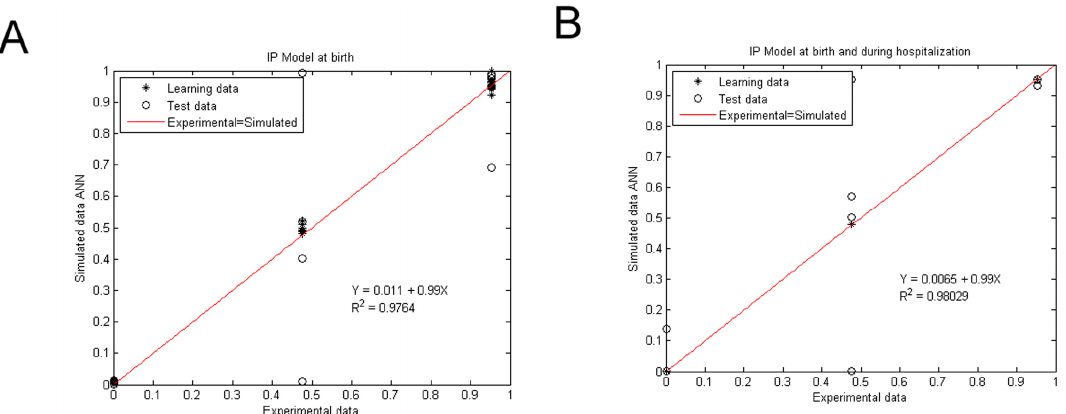
Figure 3. Experimental vs. ANN-simulated values for IP diagnosis estimation. Scatter plot of IP model at birth ( A ) and at birth and during hospitalization ( B ). Red lines indicate the linear regression model on scatter points. Open circles and closed diamonds show experimental and learning data, respectively.